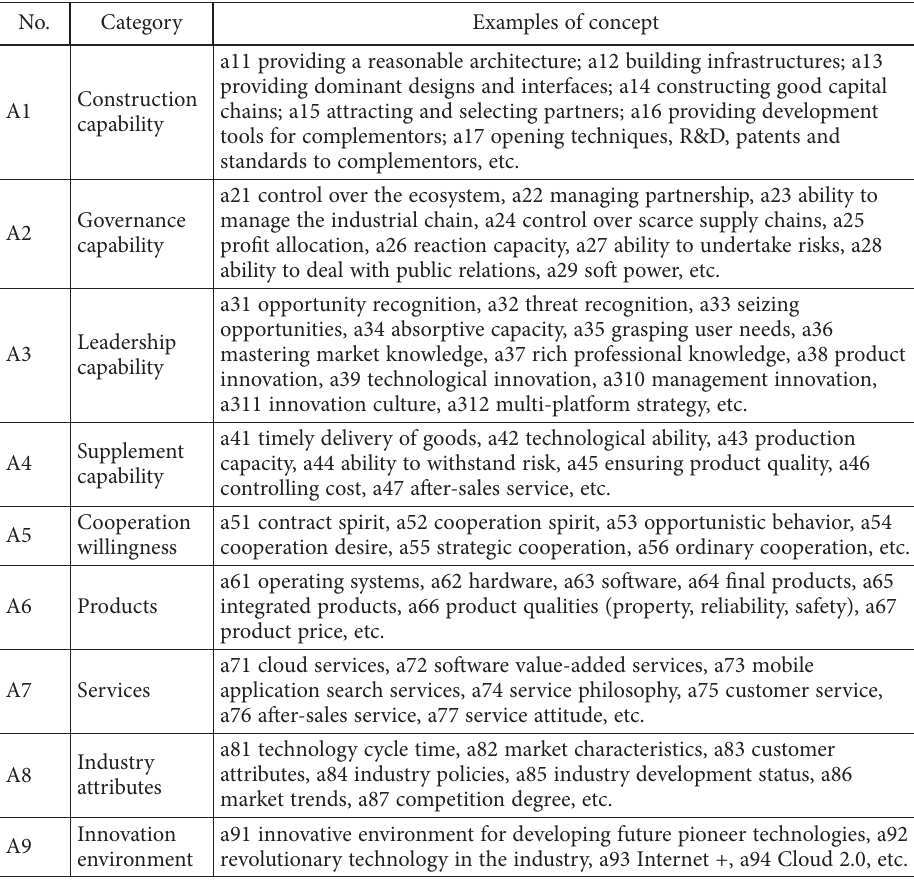
Table 2. Categories and concepts of open coding